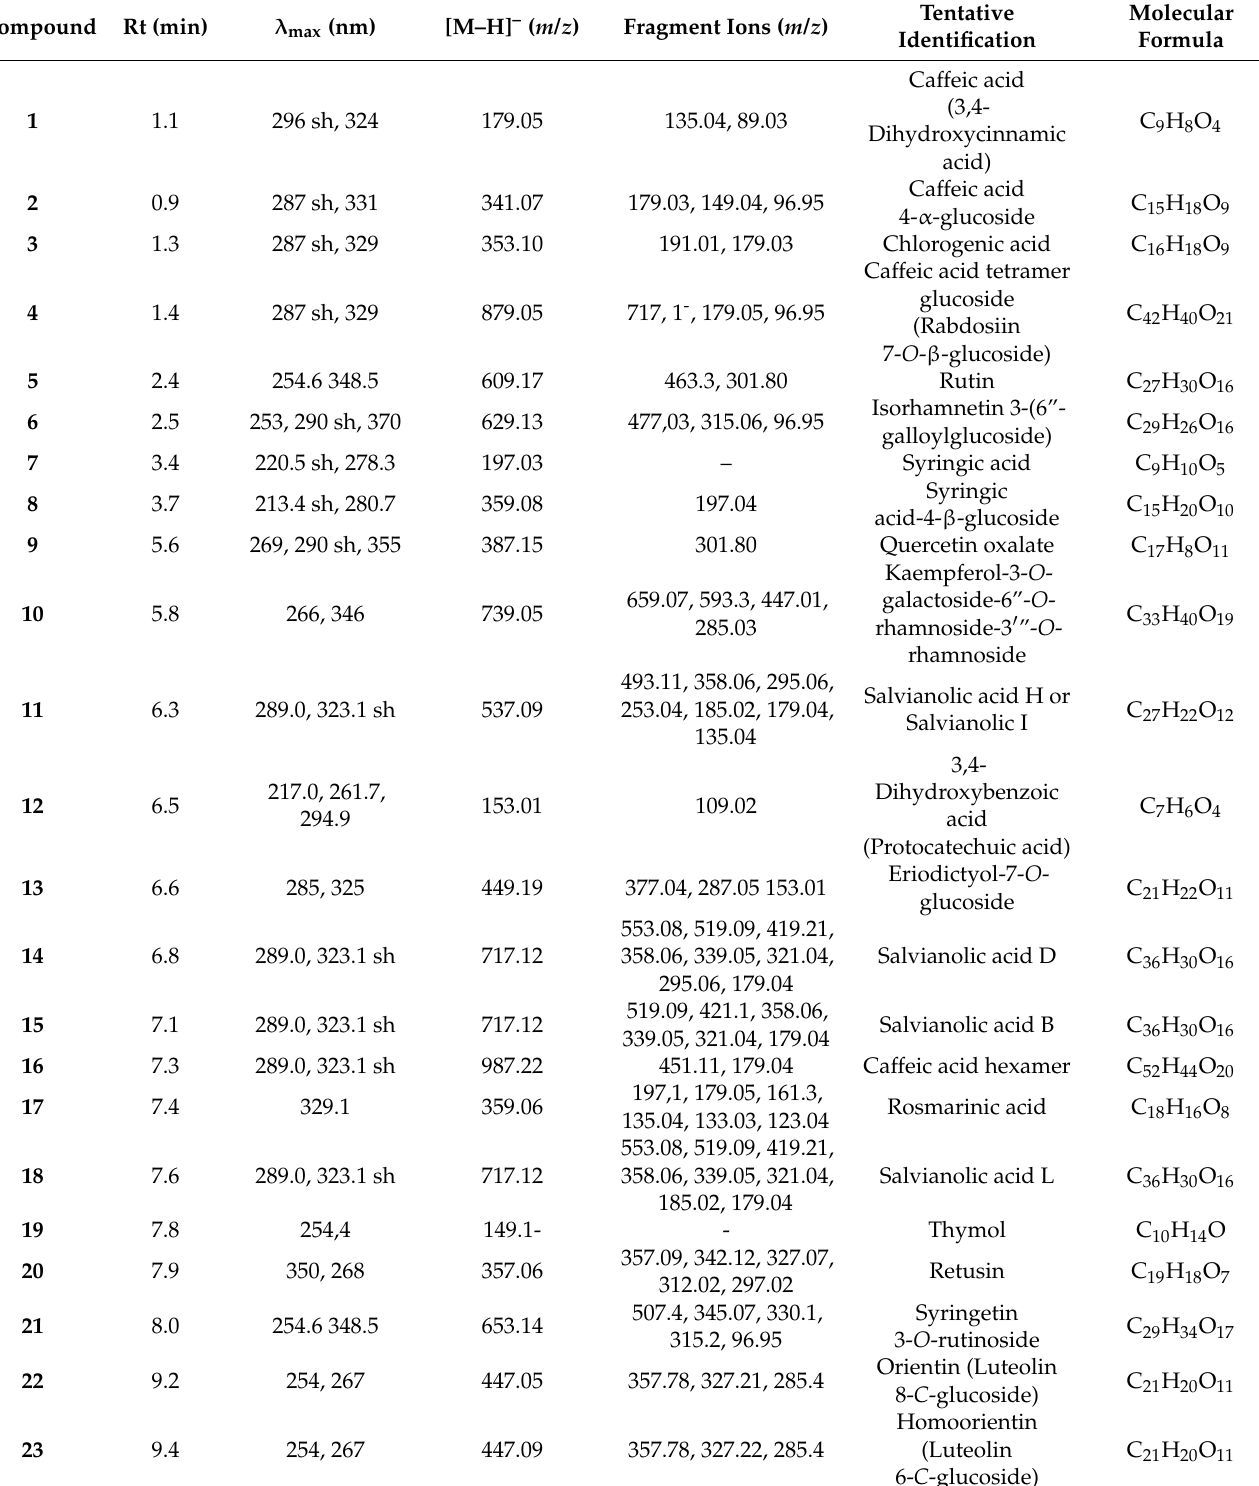
Table 2. Spectrometric data, identification and molecular formula of phenolic constituents of ethanolic extract from Origanum vulgare ssp. vulgare aerial